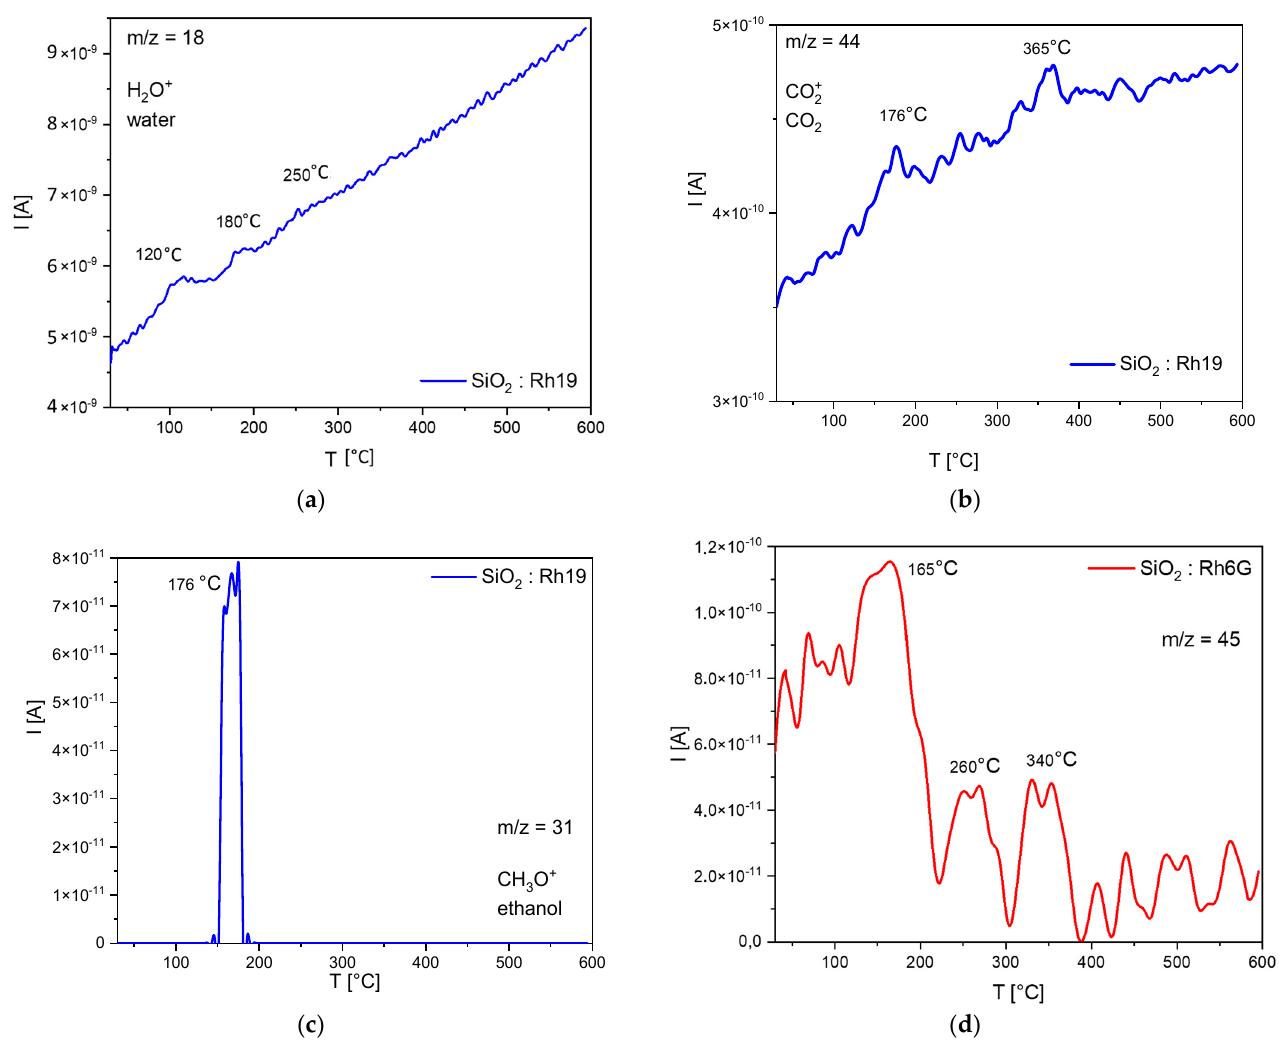
Figure 4. QMS − QMID (quadrupole mass analyzer-quasi multiple ion detection) analysis results for m/z (mass − to − charge ratio): ( a ) 18, ( b ) 44, ( c ) 31, ( d ) 45.